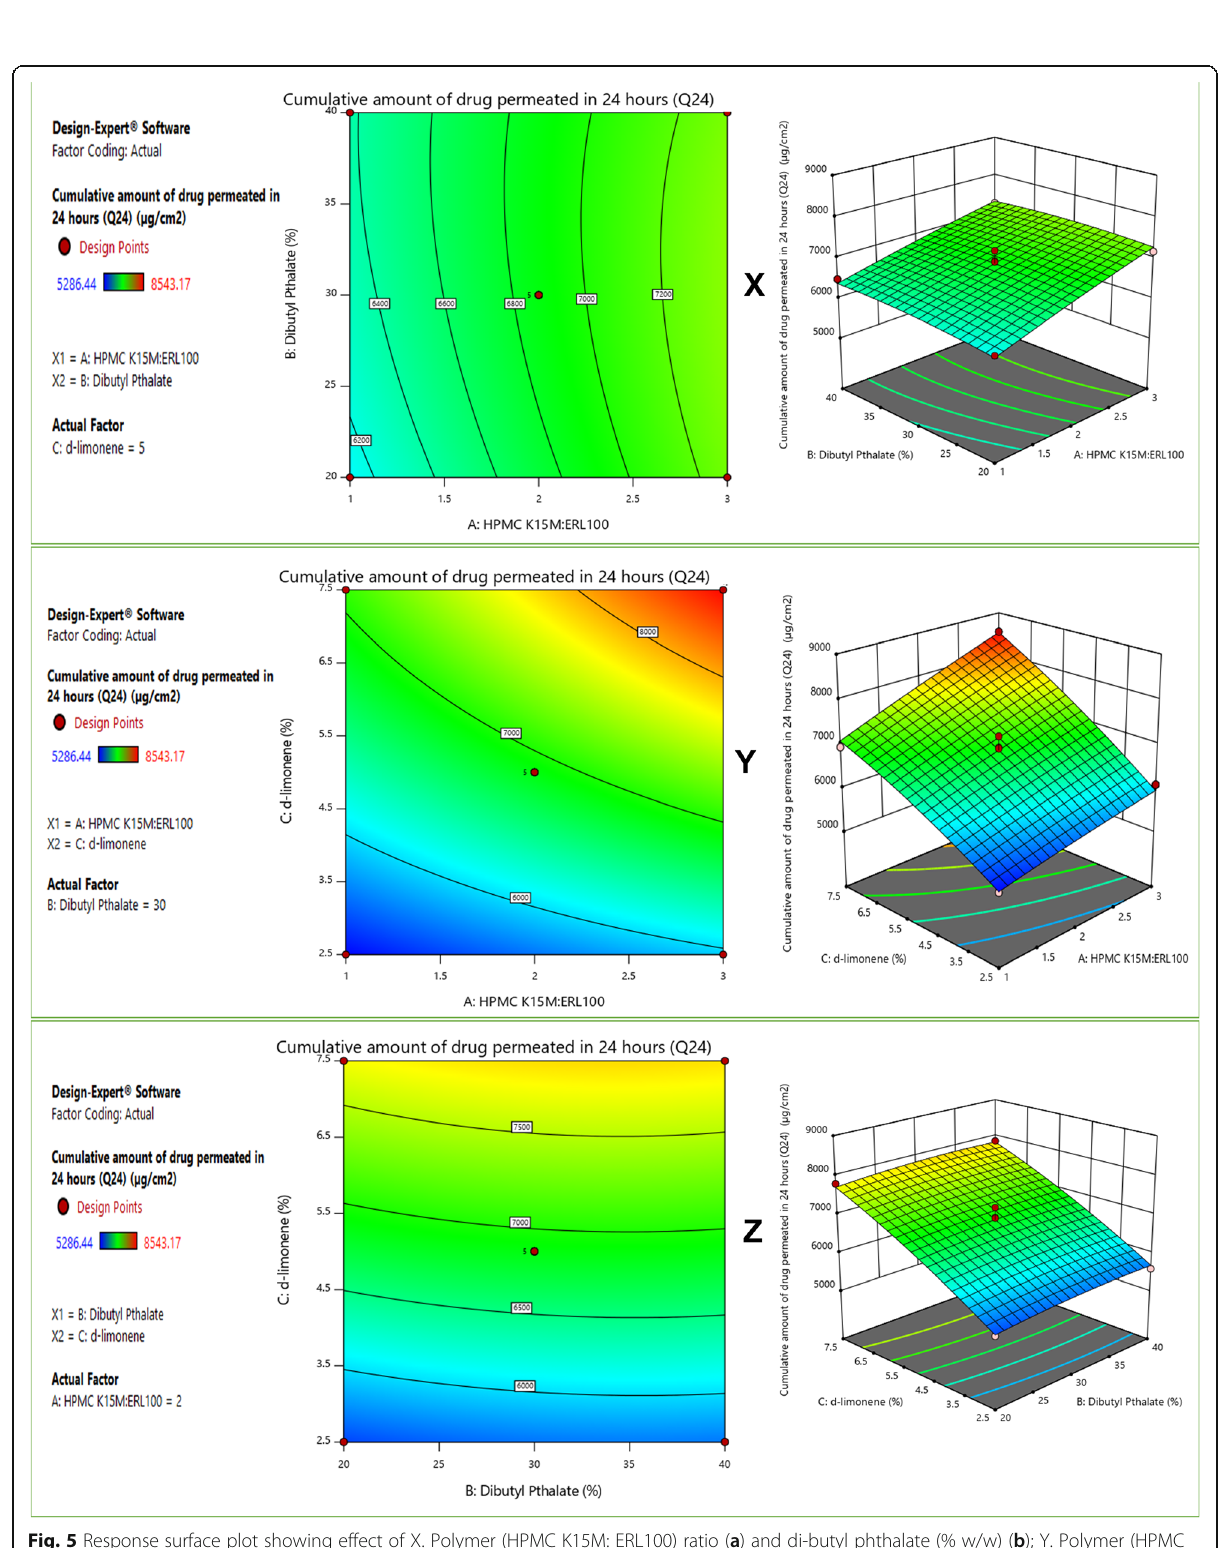
Fig. 5 Response surface plot showing effect of X. Polymer (HPMC K15M: ERL100) ratio ( a ) and di-butyl phthalate (% w/w) ( b ); Y. Polymer (HPMC K15M: ERL100) ratio ( a ) and Concentration of d-limonene (% w/w) ( c ); Z. di-butyl phthalate (% w/w) ( b )) and Concentration of d-limonene (% w/ w) ( c ) n response R 3 (Cumulative amount of drug